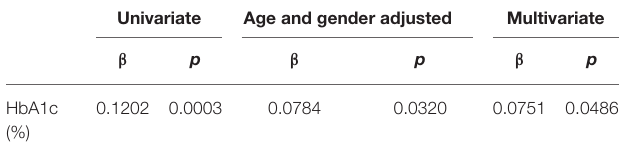
TABLE 4 | Correlation of HbA1c with P-IES